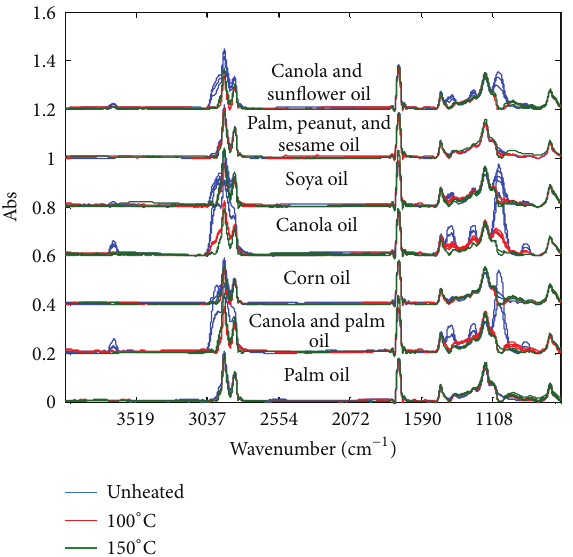
Figure 2: The FTIR spectra of seven edible oils treated under different temperatures, unheated, 100 ∘ C and 150 ∘ C.